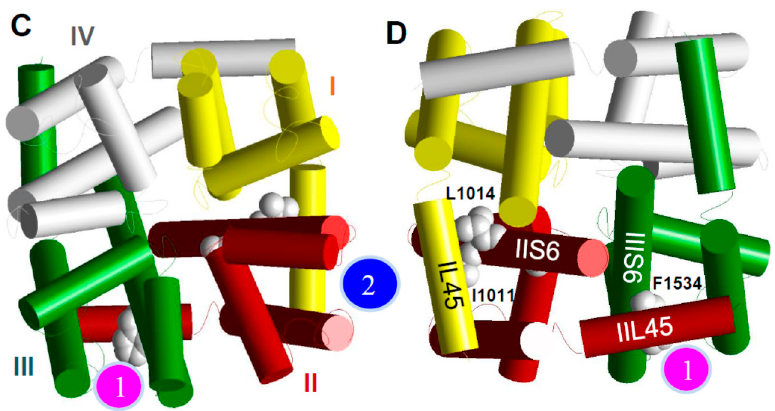
Figure 3. The pore-domain model of the mosquito sodium channel. ( A , B ), Side views; ( C ) Extracellular view; ( D ) Intracellular view. Helical segments of the channel protein in domains I, II, III, and IV are shown as yellow, red, green, and gray cylinders, respectively. Location of the pyrethroid receptor sites PyR1 and PyR2 is indicated by the magenta and blue circles, respectively. The four positions where three kdr mutations are detected in the mosquito sodium channel and another kdr mutation (L1014F) in other insect sodium channels are shown as space-filled side chains of the wild-type residues. Only carbon atoms (gray spheres) in these side chains are shown, whereas the hydrogen atoms are removed for clarity. Note that opposite faces of helix IIS6 contain residues that contribute to PyR1 (V1016) or PyR2 (I1011 and L1014).